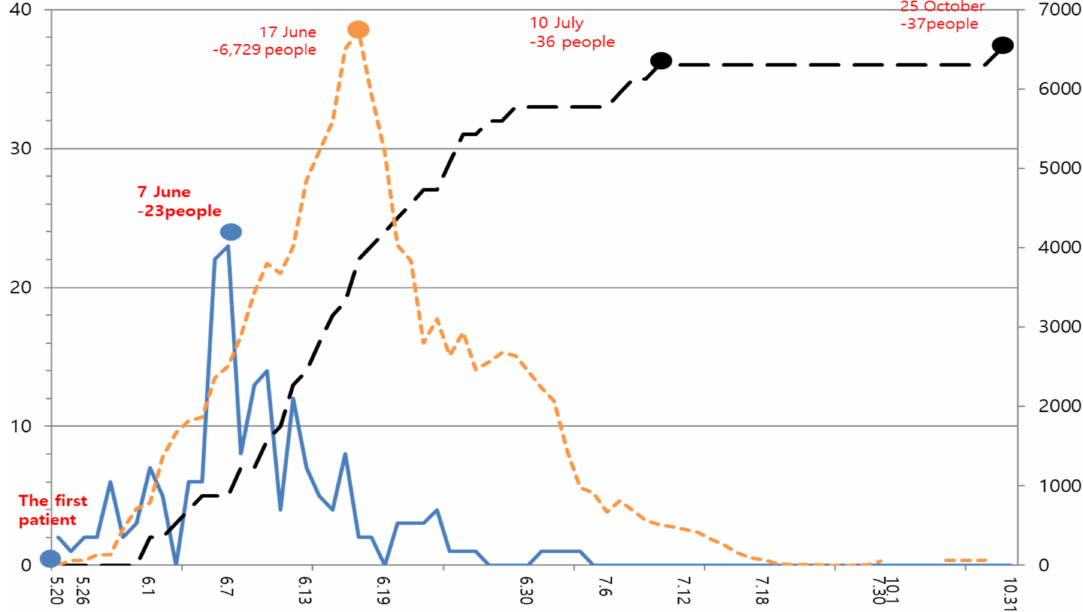
Figure 1. Statistics on the incidence of Middle East Respiratory Syndrome. Note: black line, the number of deaths; dark blue dotted line, the number of confirmed cases with MERS; light yellow dotted line, the number of quarantined cases. Data source: Seoul metropolitan government